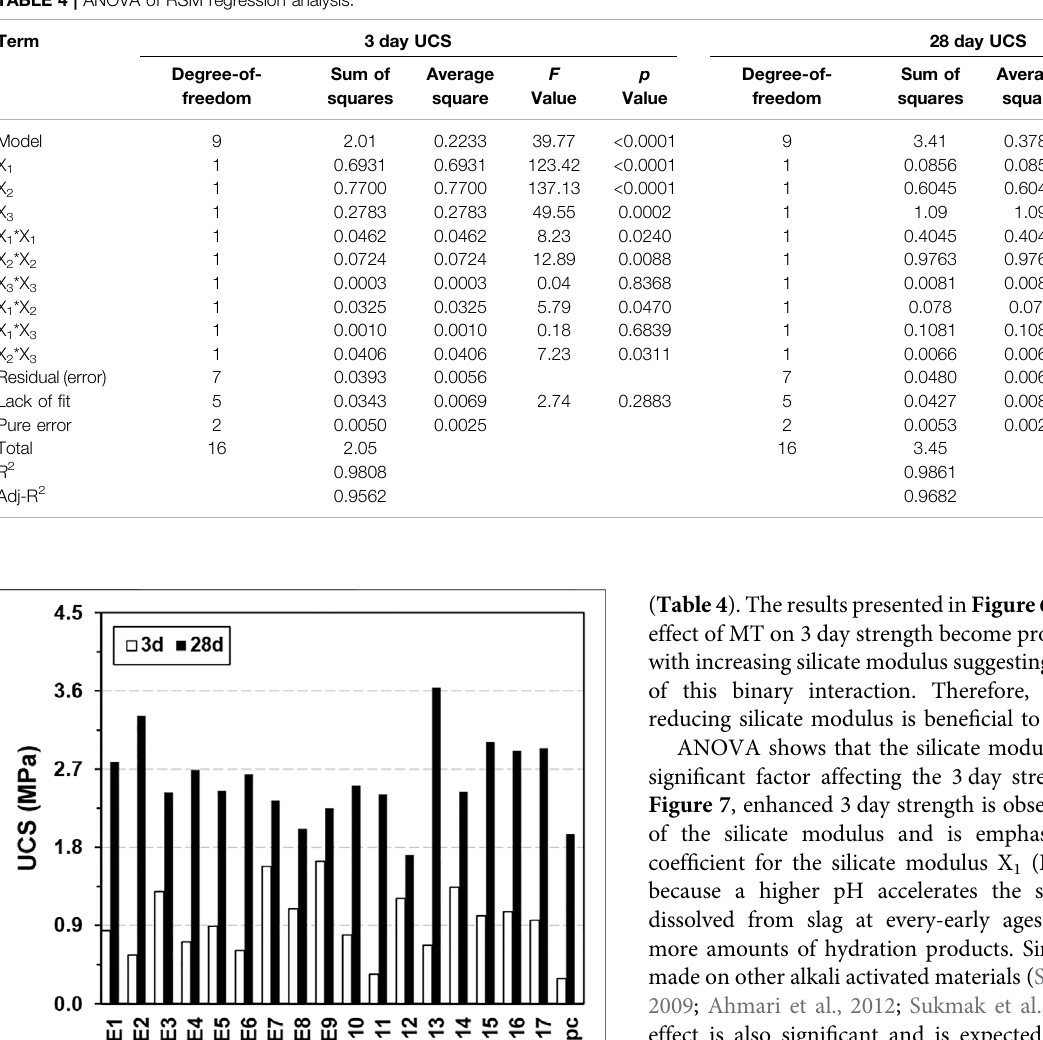
TABLE 4 | ANOVA of RSM regression analysis.